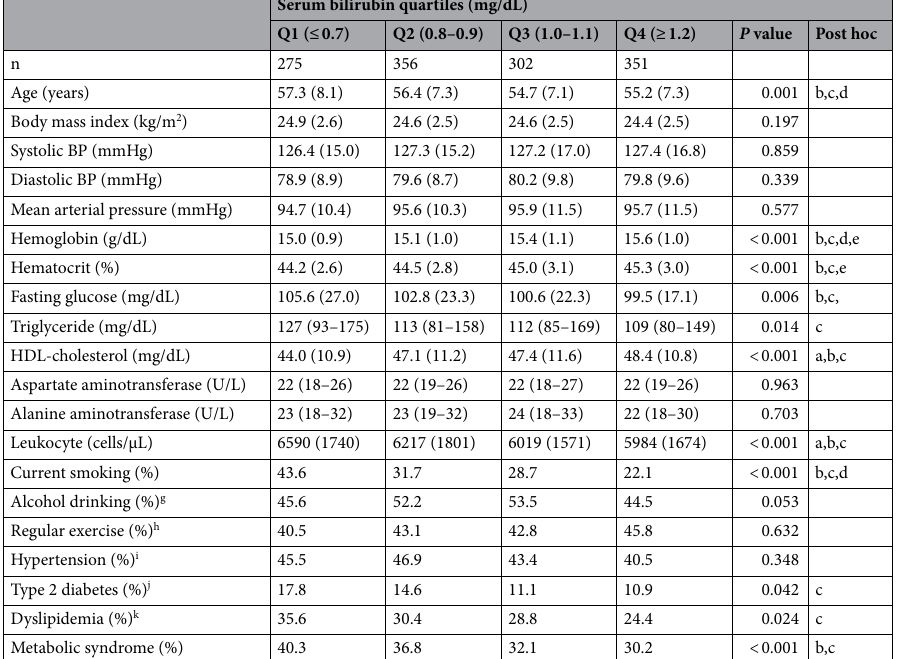
Figure 1 presents the prevalence of subjects with testosterone deficiency in each bilirubin quartile. The overall prevalence of testosterone deficiency was 5.8% and significantly decreased in accordance with serum bilirubin quartile (Q1 8.1%, Q2 7.0%, Q3 4.9%, and Q4 3.3%) ( P = 0.026). Table 2 indicates the results of multiple logistic regression analysis to assess the association between serum bilirubin level and testosterone deficiency. Compared with the referent fourth quartile (serum bilirubin ≥ 1.2 mg/